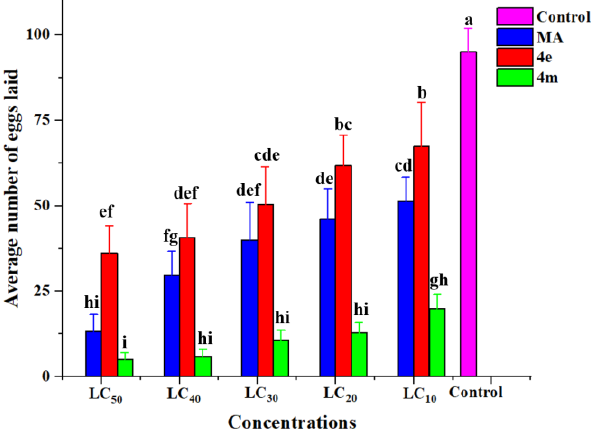
Figure 2. Effects on the emergence of larvae of Ae. albopictus : ( A ) the negative control group; ( B ) the MA treated group; ( C ) the 4e treated group; ( D ) the 4m treated group.